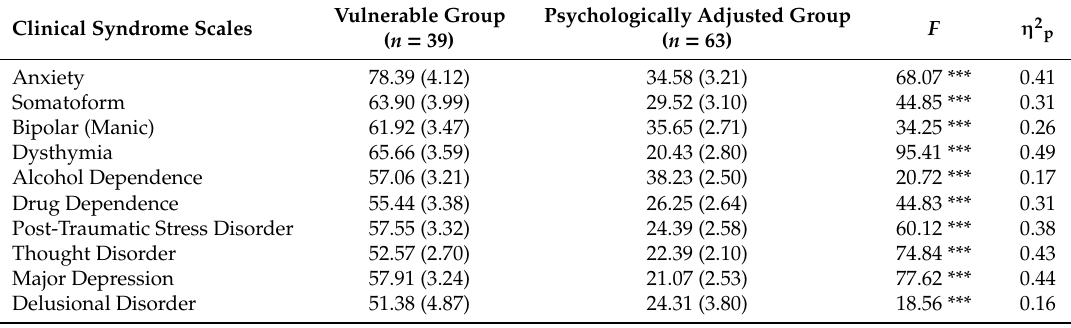
Table 3. Adjusted means (standard error in brackets) on the clinical syndrome scales, F -statistics and partial eta squared (time since diagnosis as covariates).